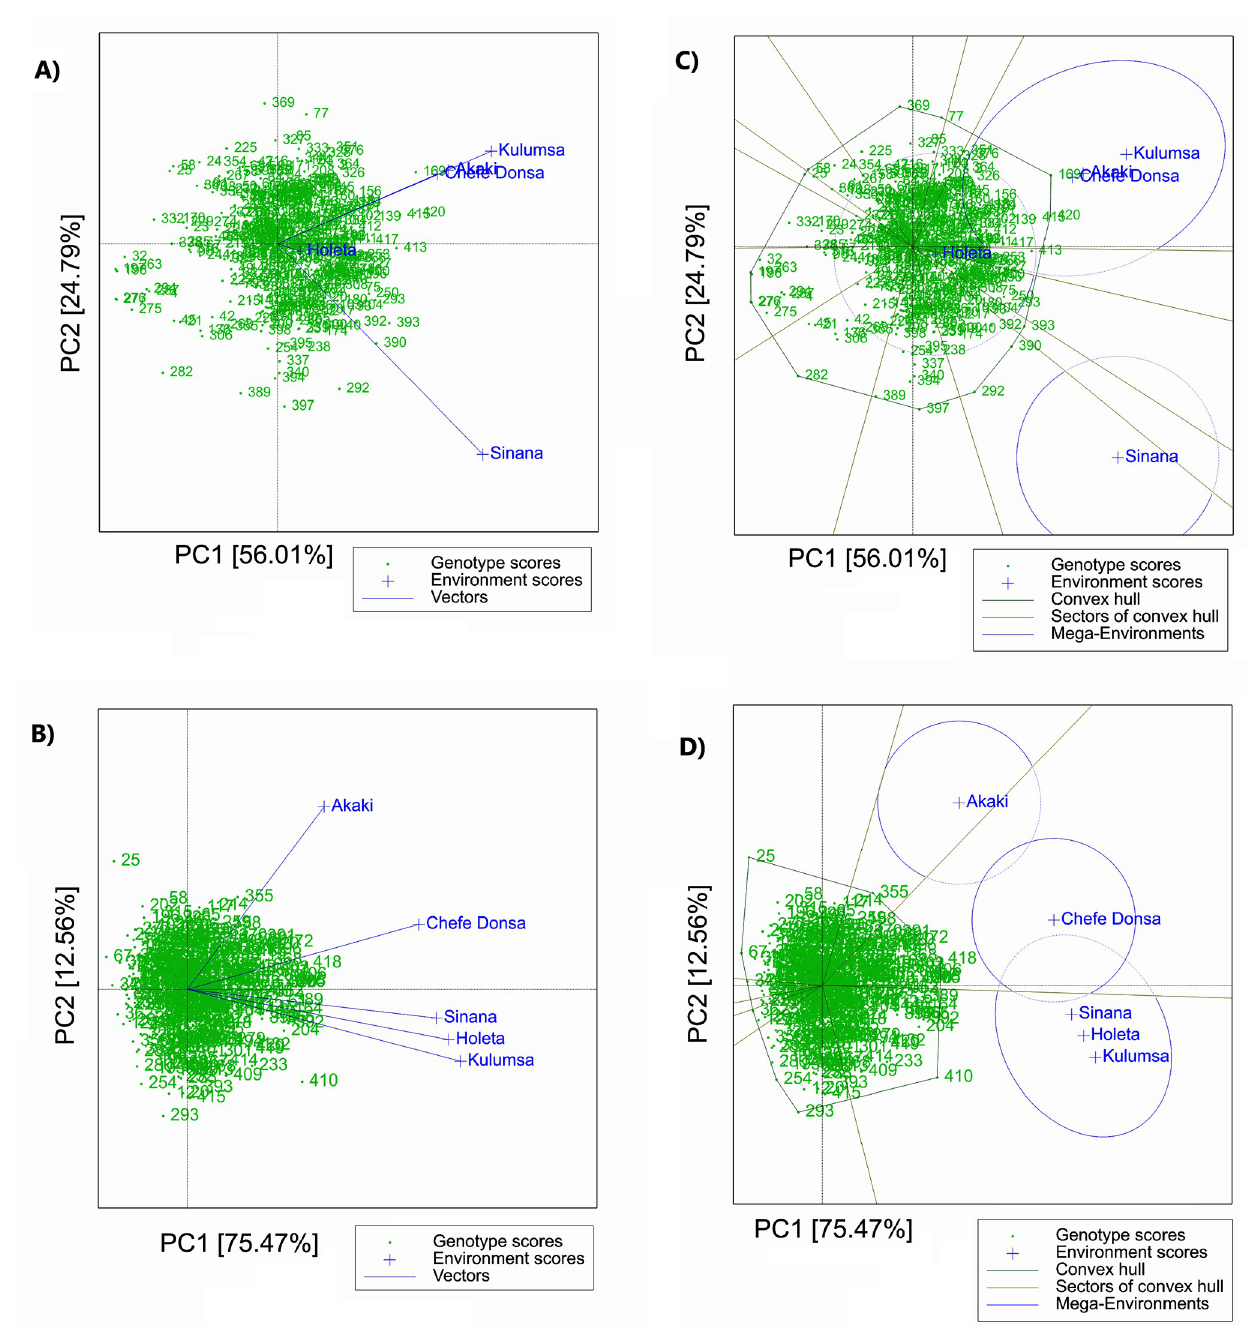
Fig 2. GGE-biplot for grain yield (A) and thousand-kernel weight (B), and polygon view of the GGE-biplot showing “which win where” pattern for grain yield (C) and thousand-kernel weight (D) under the five test